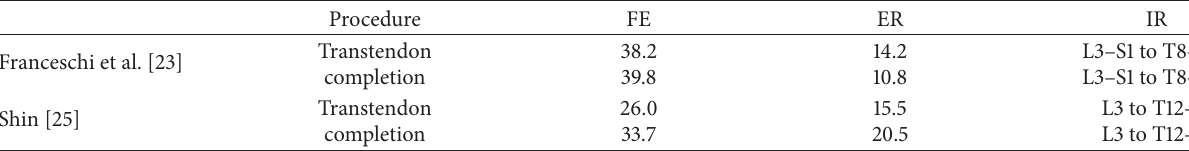
Table 4: Range of motion.